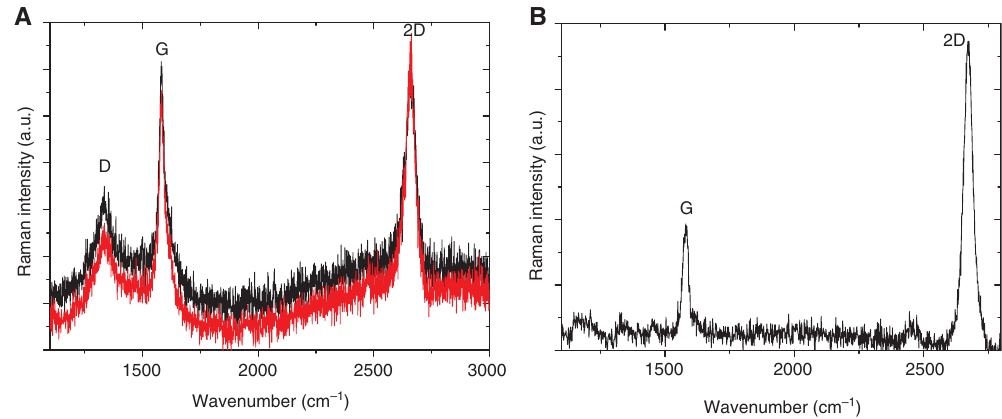
Figure 2: (A) The Raman spectrum of graphene grown on unpolished Cu foils. (B) Raman spectrum of monolayer graphene.